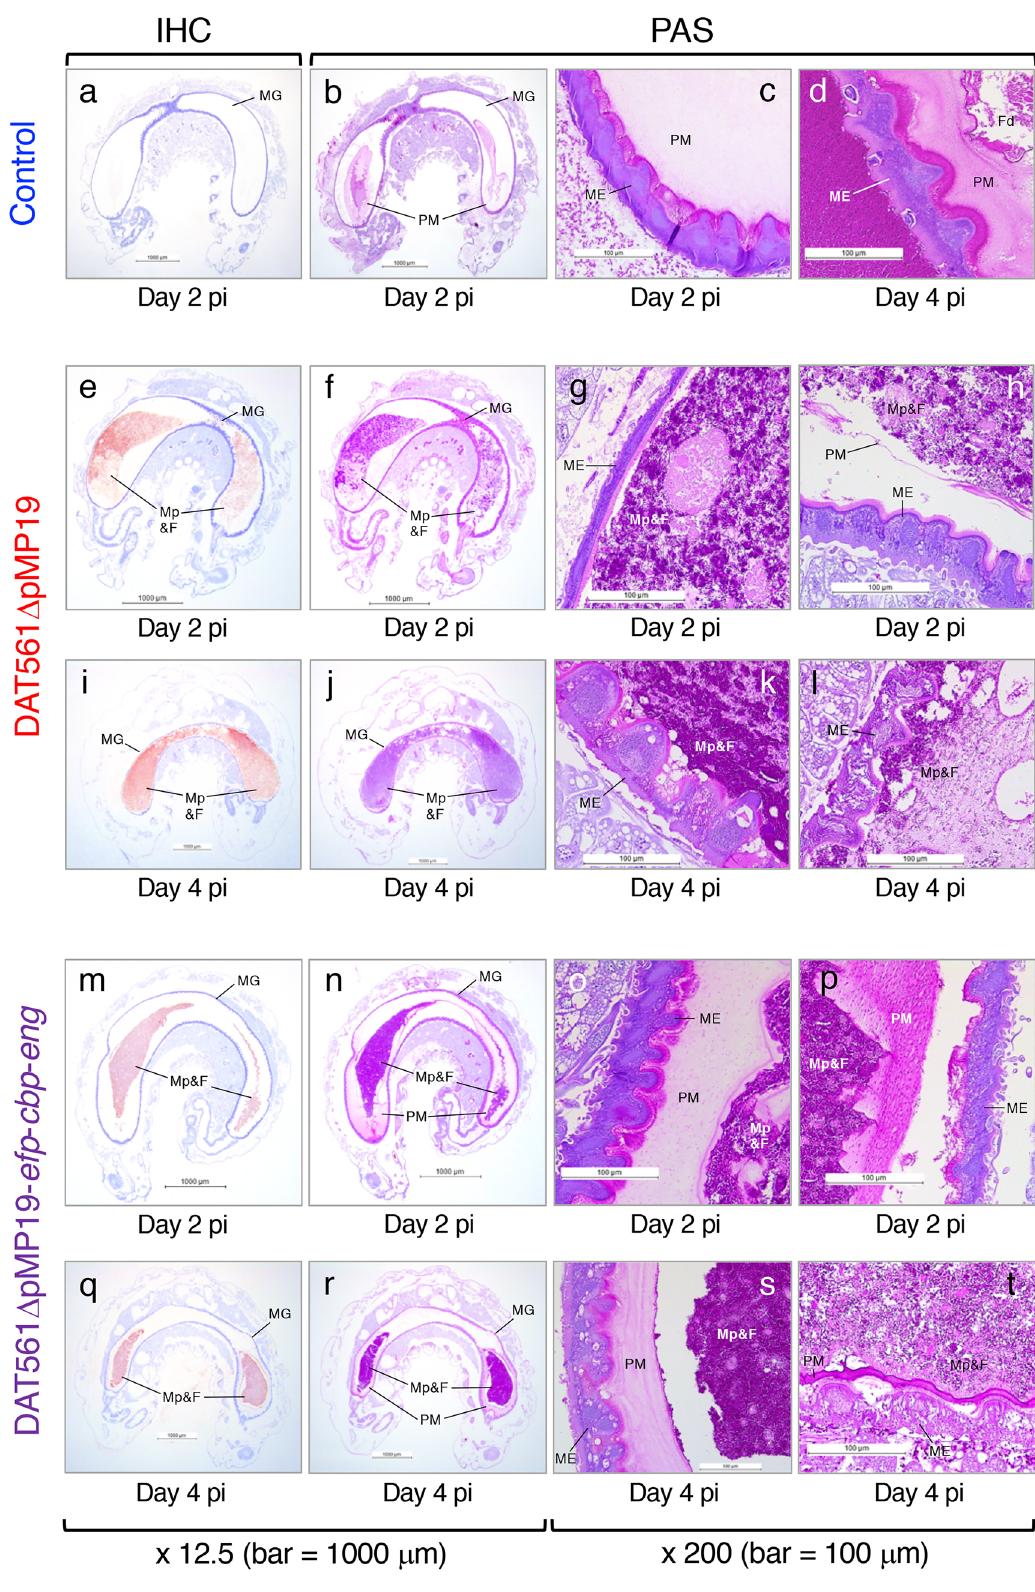
Figure 5. Light microscopic observations of representative non-infected control larvae [larva nos. 5 ( a – c ) and 8 ( d )], DAT561ΔpMP19-infected larvae [larva nos. 18 ( e – g ), 15 ( h ), 22 ( i–k ) and 21 ( l )] and DAT561ΔpMP19- efp - cbp - eng -infected larvae [larva nos. 31 ( m–o ), 36 ( p ), 44 ( q–s ) and 38 ( t )] (refer to Supplementary Table S5 for information about each larva). Surviving larvae were collected at days 2 and 4 post-infection (pi) (days 4 and 6 post-grafting). The larvae were then fixed, dehydrated, embedded in paraffin and sectioned. The sections were stained using the periodic acid-Schiff (PAS) reaction and immunohistochemical (IHC) staining with rabbit polyclonal antiserum against M. plutonius cells 25 . MG, midgut; PM, peritrophic matrix; ME, midgut epithelial cells; Fd, brood foods in the midguts; Mp&F, M. plutonius and brood foods in the